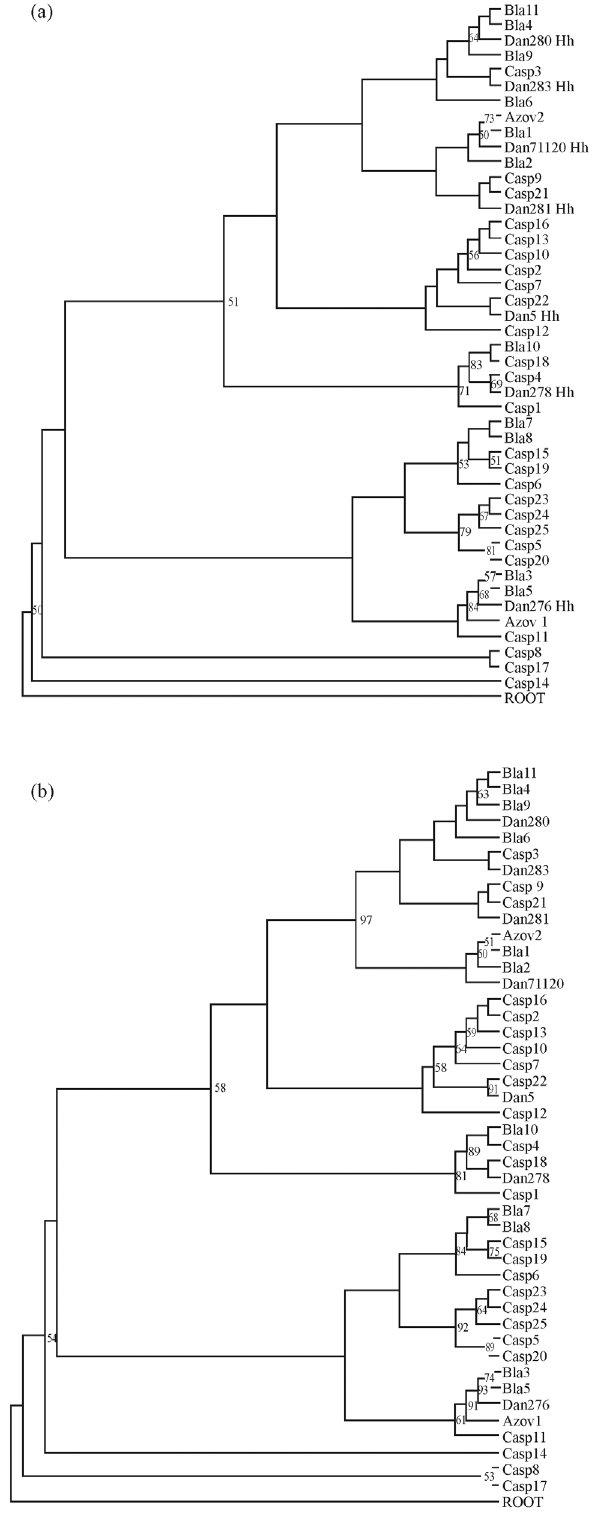
Figure5 -Median-JoiningnetworksforD-loopmtDNAhaplotypesin(A) H.huso, (B) A.stellatus and(C) A.gueldenstaedtii populations.Circlesize isproportionaltohaplotypefrequency.Fullblackcirclesrepresentmedian vectors (missing haplotypes). Colors indicate the geographic origin of haplotypes. Branch lengths are proportional to the number of substitutions per nucleotide